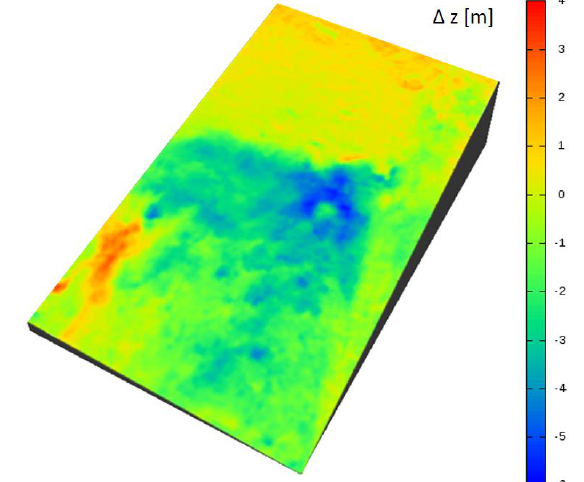
Figure 10. Altitude difference map between Oct. 2008 and Oct.